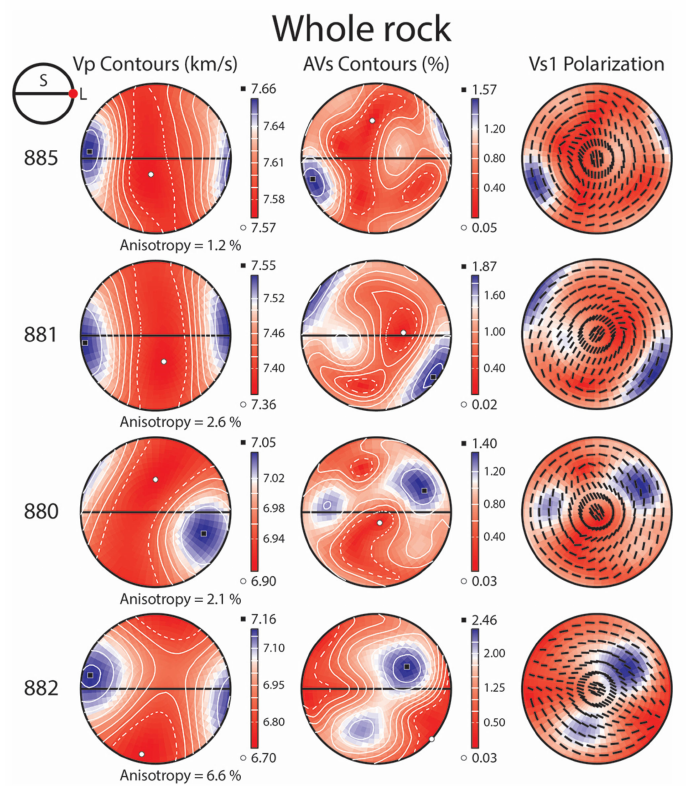
Figure 10. Seismic velocity and anisotropy of whole-rock P-wave velocity (V P ) and seismic anisotropy of S-wave (AV S ) are shown. V S 1 polarization indicates the polarization direction of the fast shear wave (V S 1). S and L represent foliation and lineation,